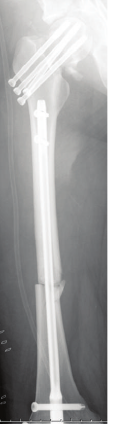
Figure 1: Initial radiographs of the fracture sites. (a) An anteropos- terior pelvic radiograph showing an AO type B3 fracture of the right acetabulum and AO type C3 fracture of the right femoral neck. (b) An anteroposterior radiograph showing an AO type A3 fracture of the right femoral shaft with a Gustilo type 2 open wound.